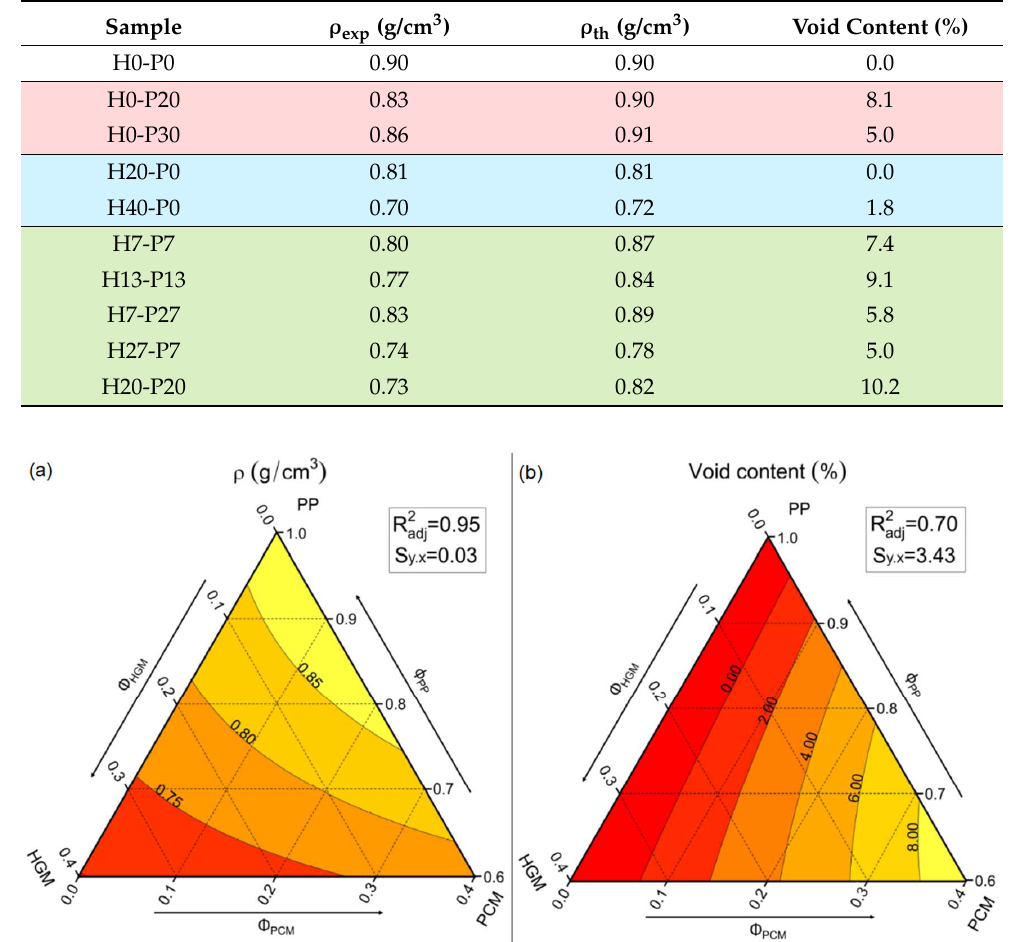
Figure 4. Ternary diagram of ( a ) the experimental density and ( b ) the void content of the prepared foams.